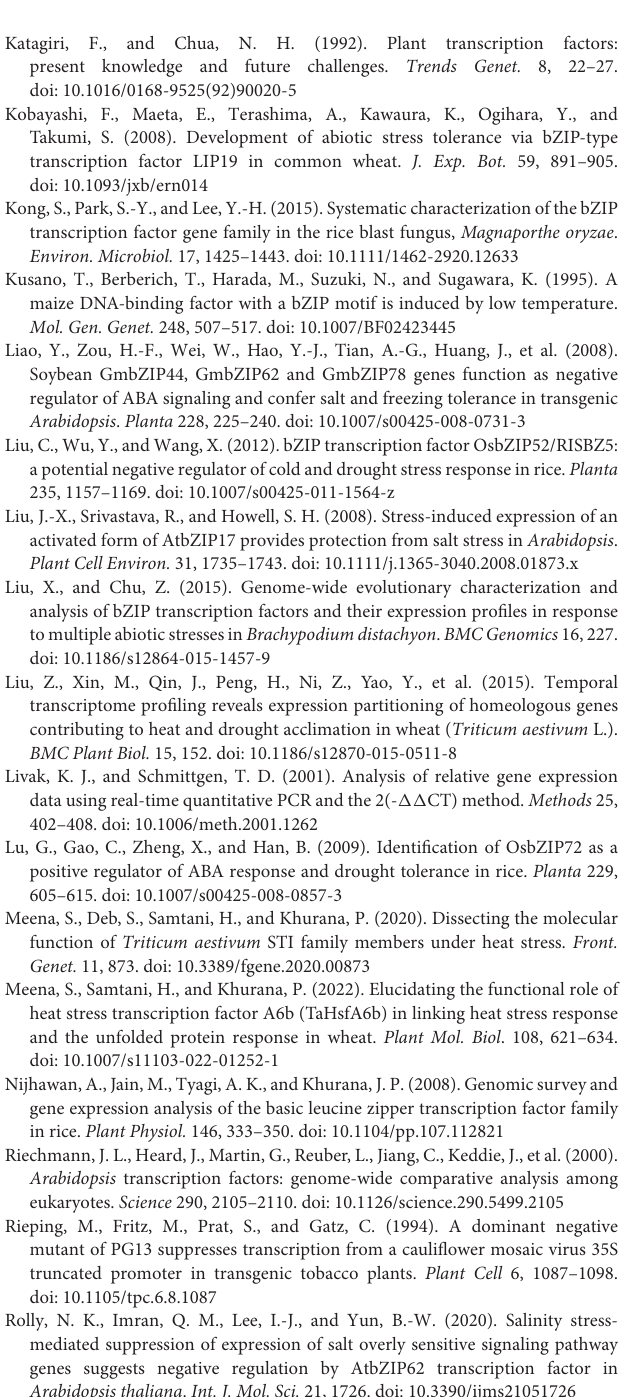
Supplementary Figure 8 | Confirmation of TaOBF1-5B overexpression rice transgenic lines by (A) Hygromycin resistance gene specific PCR (B) Gene and vector-specific PCR (C) RT-PCR. Supplementary Table 1 | List of primers used in this